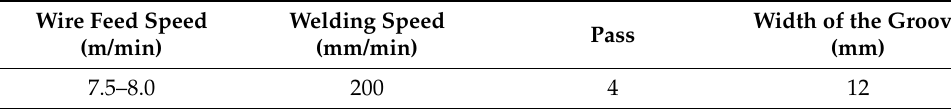
Table 9. Parameters picked for microstructure